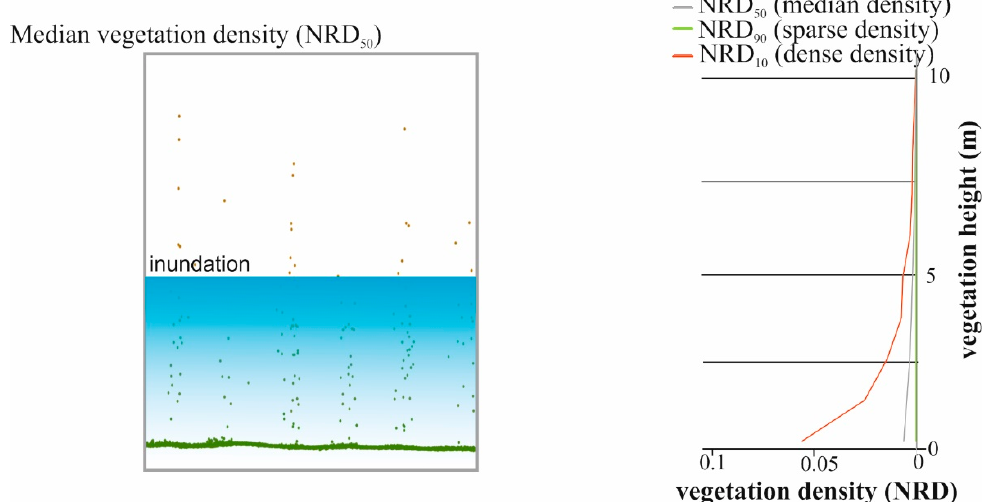
Figure 8. LiDAR point distribution in voxels with sparsely and densely vegetated young poplar plantations, and characteristic vertical distribution of their vegetation density.